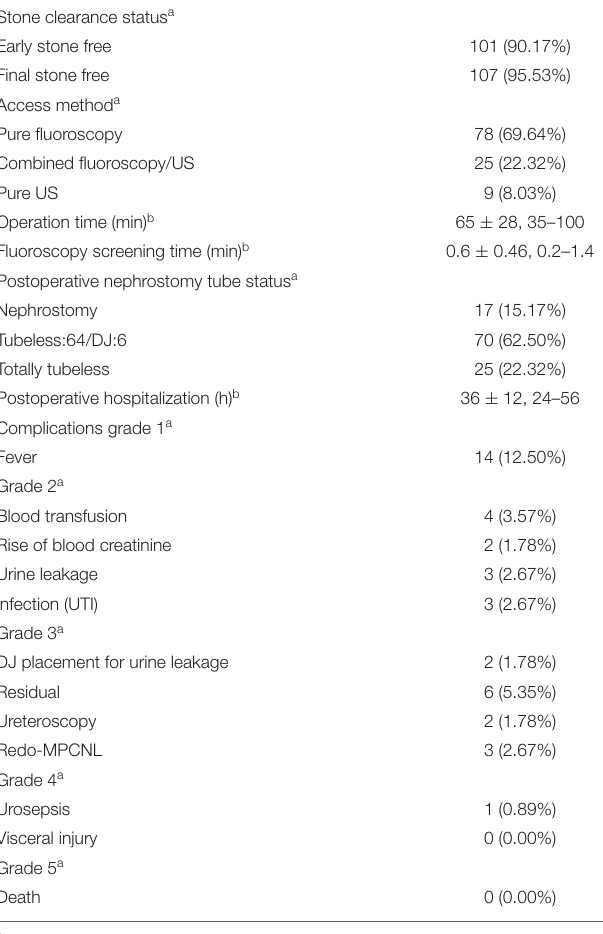
TABLE 2 | Outcome and complications of MPCNL surgery of 112 pediatric